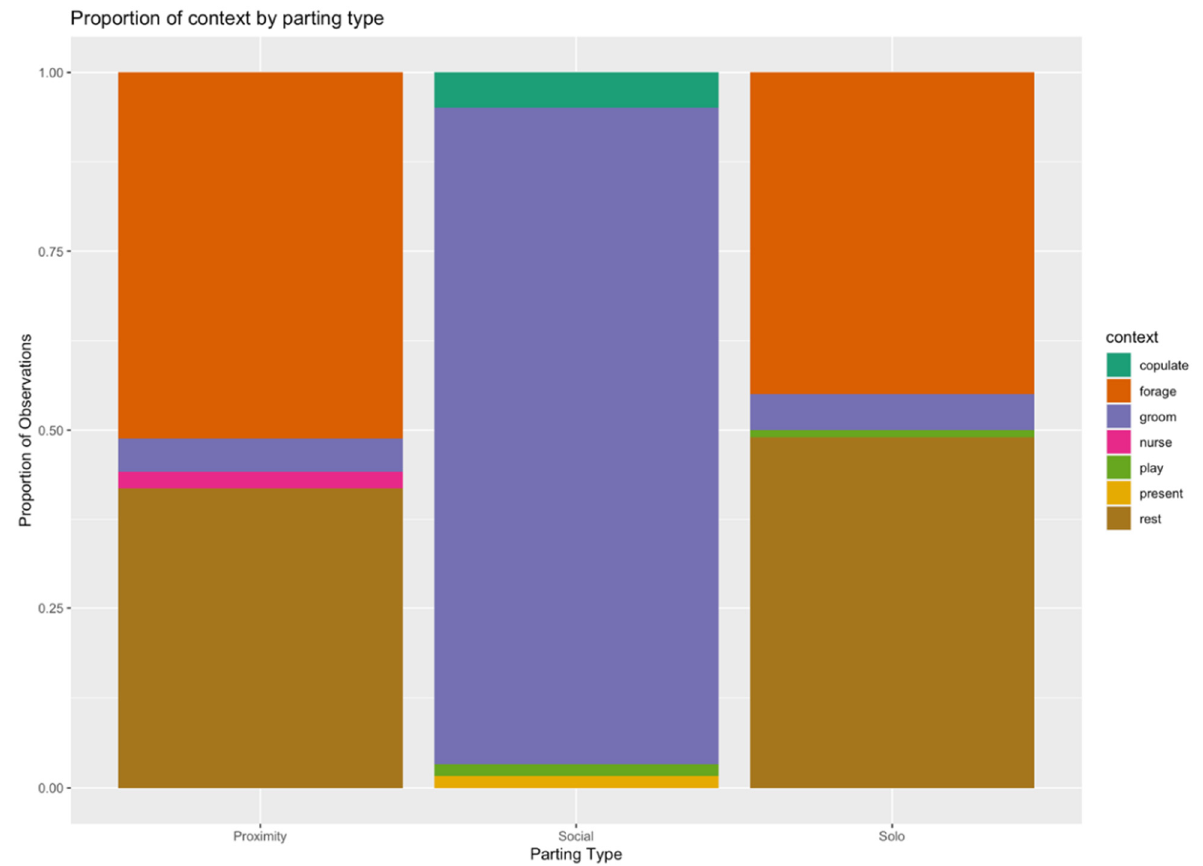
Figure 3. Proportion of context by parting type .